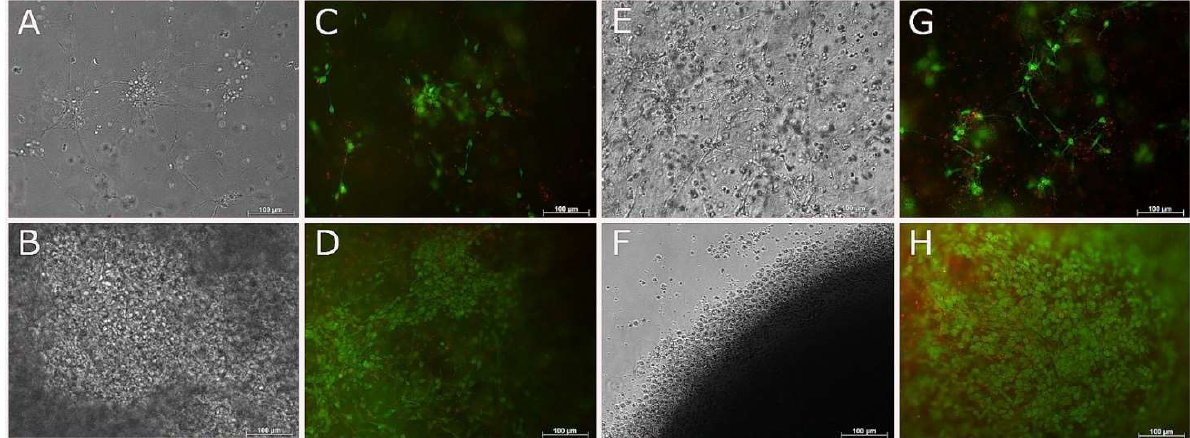
Figure 8. Live and Dead images of RenCell VM neural progenitor cells encapsulated in 2.5/mL fish collagen. Phase contrast ( A , B , E , F ) and live and dead ( C , D , G , H ) images taken of RenCell VM at 7 ( A – D ) and 14 ( E – H ) days. Top and bottom rows correspond to cells cultured with differentiation media and growth media, respectively. Scale bars represent 100 µm.